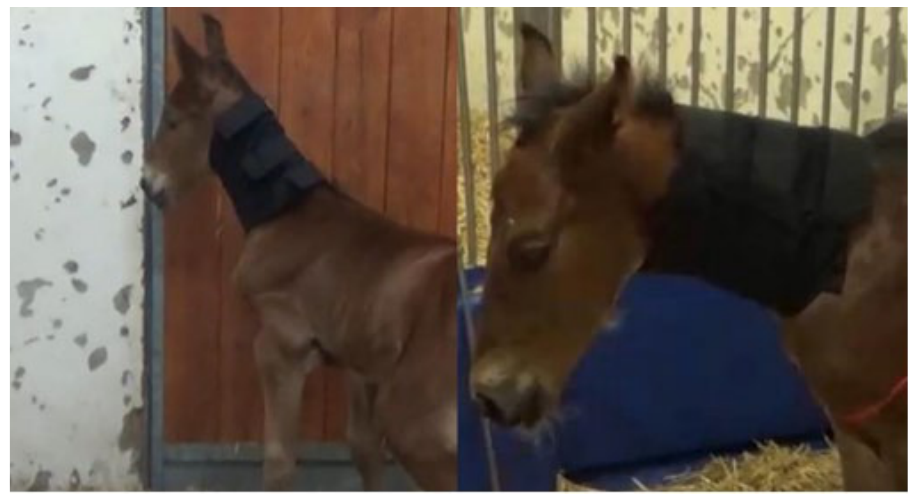
Figure 1. One of the foals used in the study wearing the collar applied to hide the possible presence of an intravenous catheter on the neck during the video recording.